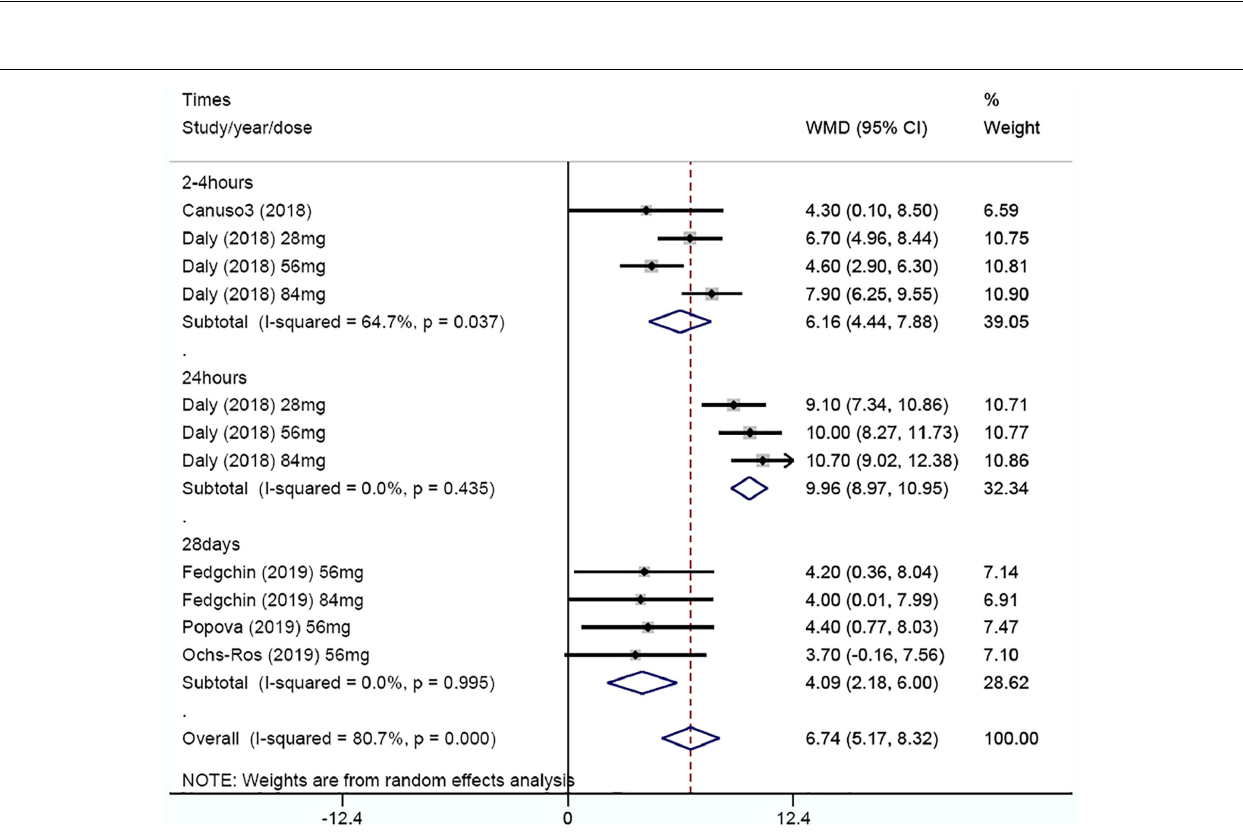
Frontiers in Psychology |